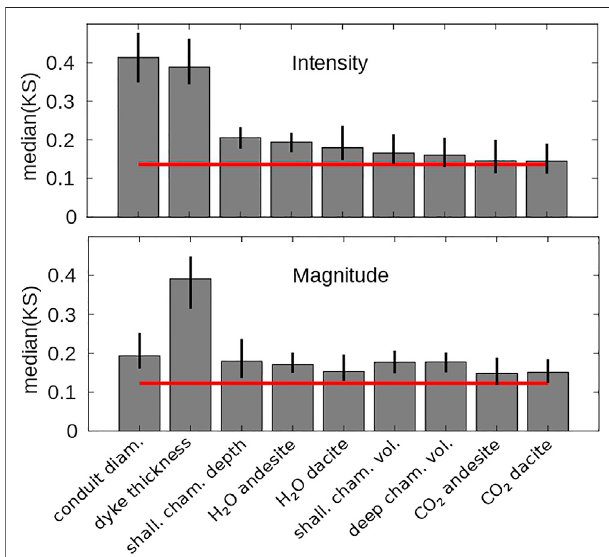
FIGURE 6 | PAWN sensitivity indices as the median KS across conditioning intervals (stat (cid:2) median in Eq. 8 ), for sample size N (cid:2) 719 and number of conditioning intervals n (cid:2) 10. Vertical line represents the 95% con fi dence interval estimated by bootstrapping and the bar height indicates the mean value of each PAWN index. The red line is the KS of the dummyparameter(valuescorrespondingtobarheightslowerthantheredline areunreliable).Theanalysisisobtainedwithasamplesize N (cid:2) 719,andsetting a number of conditioning intervals n (cid:2) 10 suf fi cient to reach the convergence of the PAWN sensitivity indices (see also Supplementary Figures S2 – 5